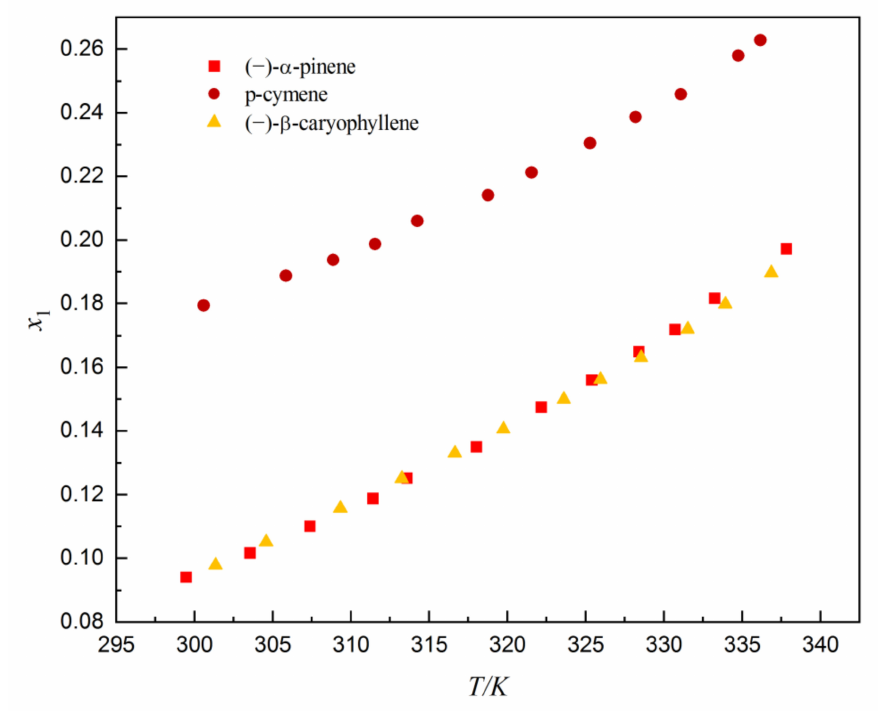
Figure 4. Mole fraction solubility of dehydroabietic acid in the three